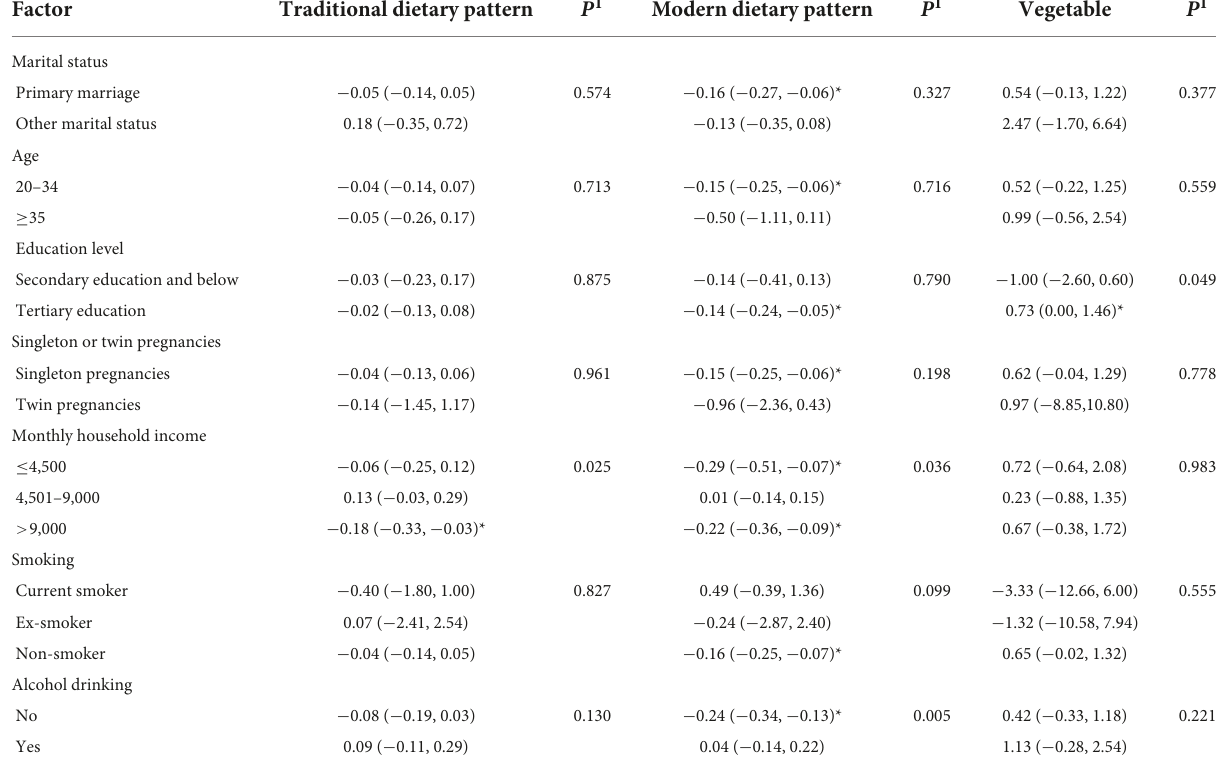
TABLE 4 Subgroup analyses of associations between modes of delivery and postpartum dietary intake # .